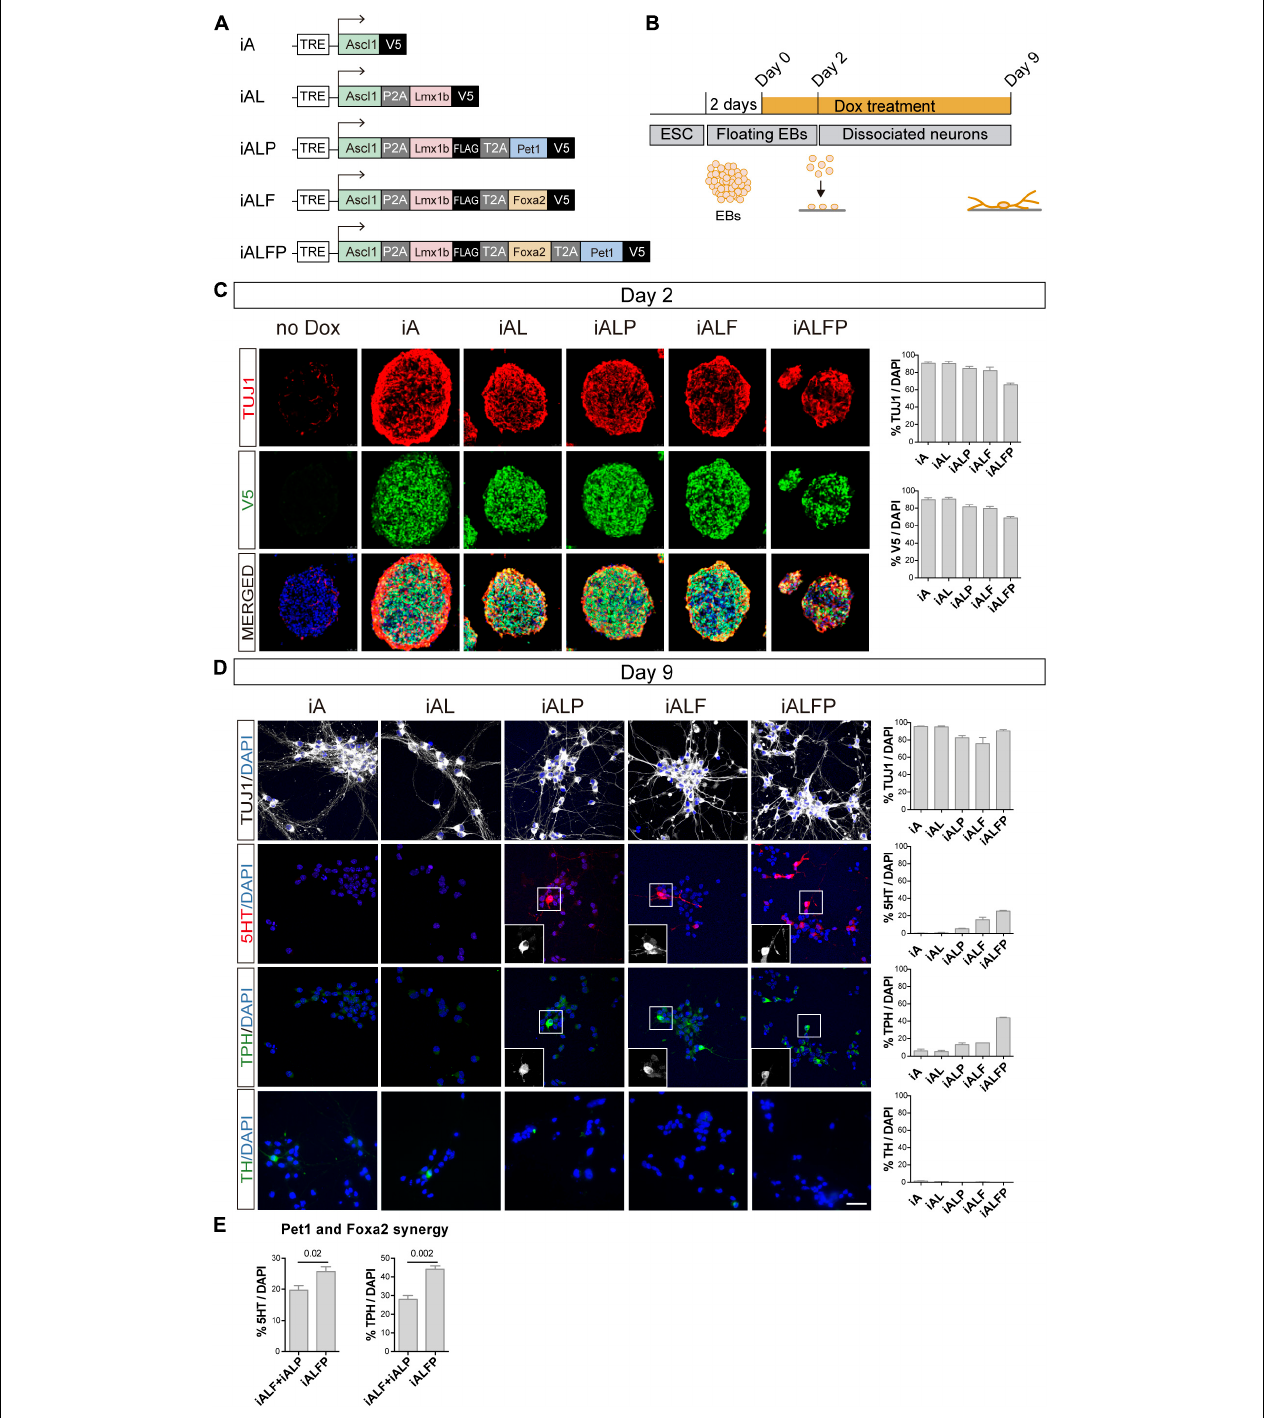
FIGURE 1 | Dissection of the combinatorial action of serotonergic TFs. (A) TF combinations induced in ESC. (B) TF induction, differentiation, and analysis outline. Doxycycline treatment is started 2 days after floating EB preparation. EBs are dissociated and plated 2 days later (Day 2) and cultured in the presence of doxycycline for 7 more days (Day 9 analysis). (C) Micrographs and quantification of TF induction (monitored by V5 expression) and neuronal fate (monitored by beta tubulin 3,TUJ1 staining) in EBs 2 days after doxycycline treatment. Broad iTF and neuronal differentiation induction in all cell lines. (D) Micrographs and quantification of neuronal (TUJ1), serotonergic (5HT and TPH) and catecholaminergic (TH) fate after 7 days of neuronal differentiation. Catecholaminergic expression is absent in all lines, while serotonergic markers are highest in iALFP. (E) Measurement of synergistic effects in iAFLP line. The addition of iALF + iALP serotonergic or TPH expression is significantly lower than values found in iALFP, suggesting synergistic effects between Pet1 and Foxa2. Scale bar: 50 µ m.